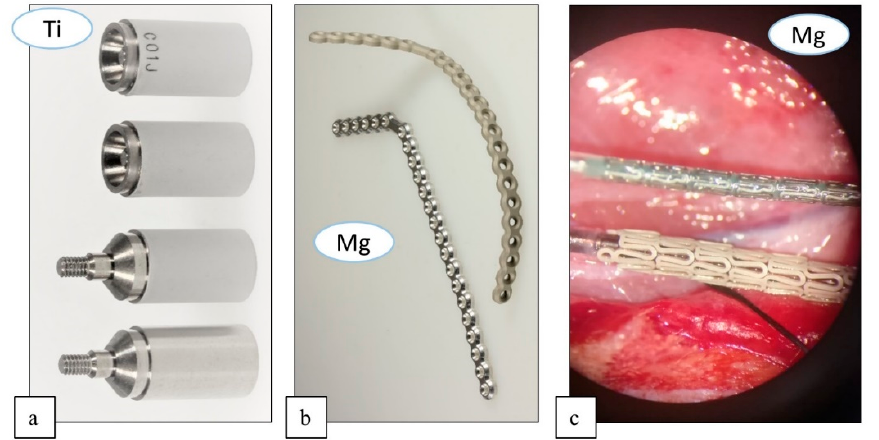
Figure 15. Application examples for PEO coatings on different substrates: scan body locators ( a ), plates for osteosynthesis before and after coating, ( b ) stent for treatment of coronary heart issues ( c ) products of Meotec GmbH [42].